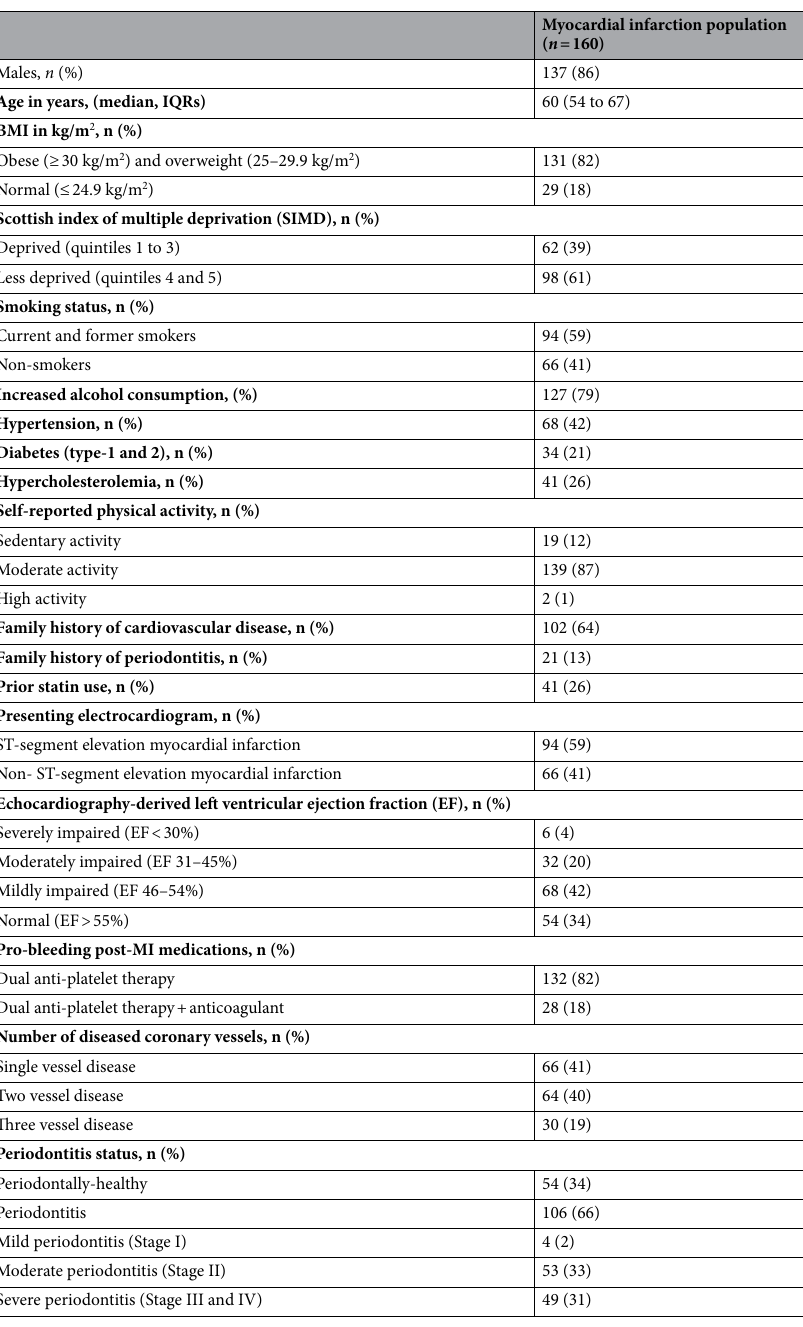
Table 1. General clinical characteristics of the study population. Descriptive categorical measures are expressed as number ( n ) and corresponding percentage